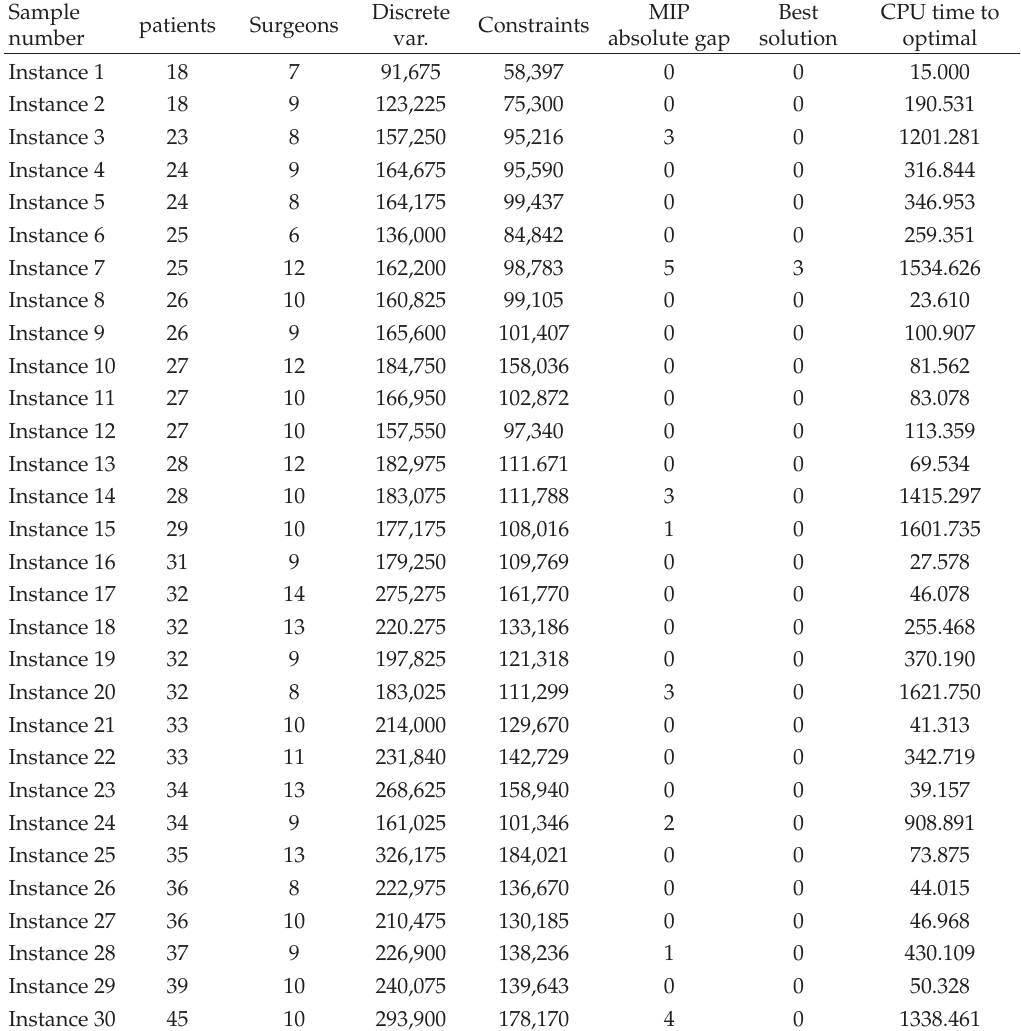
Table 1: Results of 30 test